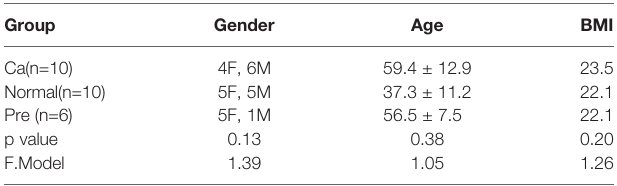
TABLE 1 | Clinical data of 26 cases of oral gargle